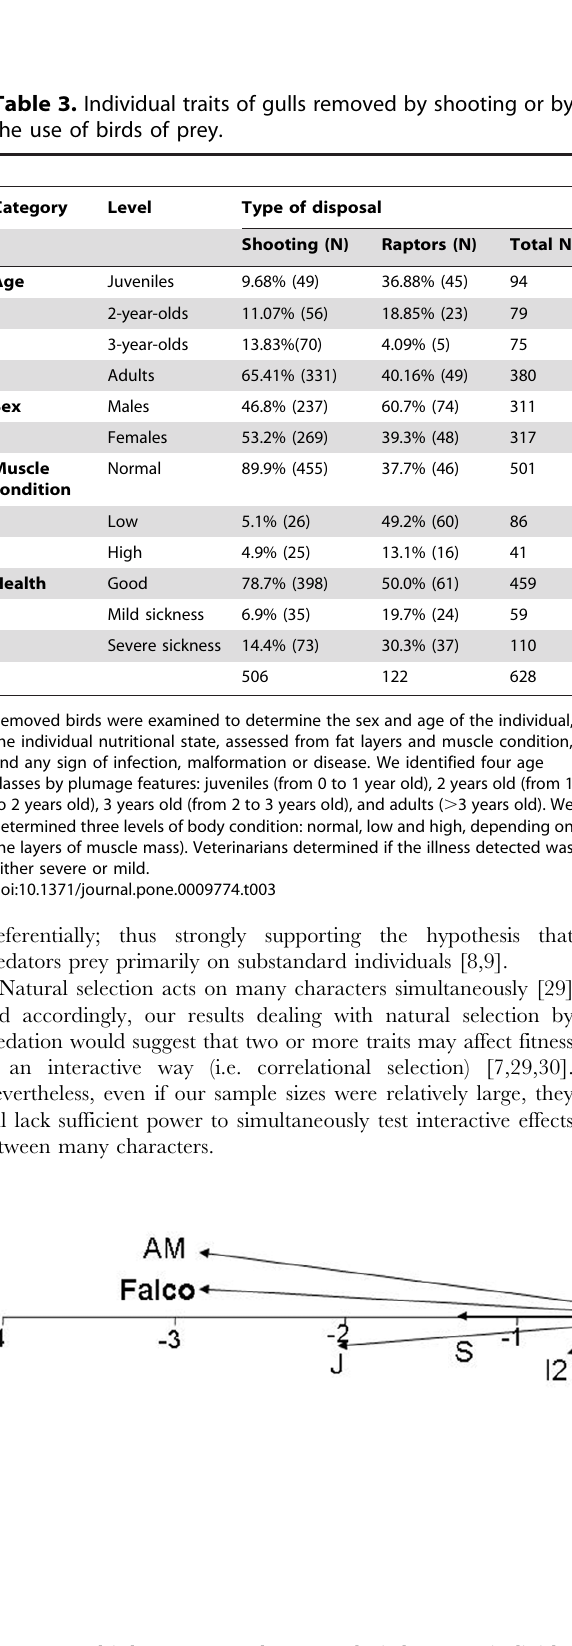
Figure 1. Multiple Correspondence Analysis between individuals shot and those killed by raptors. Map of the two main factorial axes from a Multiple Correspondence Analysis between individuals shot (noted by Shoot) and those killed by birds of prey (noted by Falco) depending on individual classification (F: Females; M: Males; J: Juveniles; I2: 2 years old; I3: 3 years old; A: Adults; H: Healthy individuals; S: Sick; AM: Abnormal muscle condition (low and high); NM: normal muscle